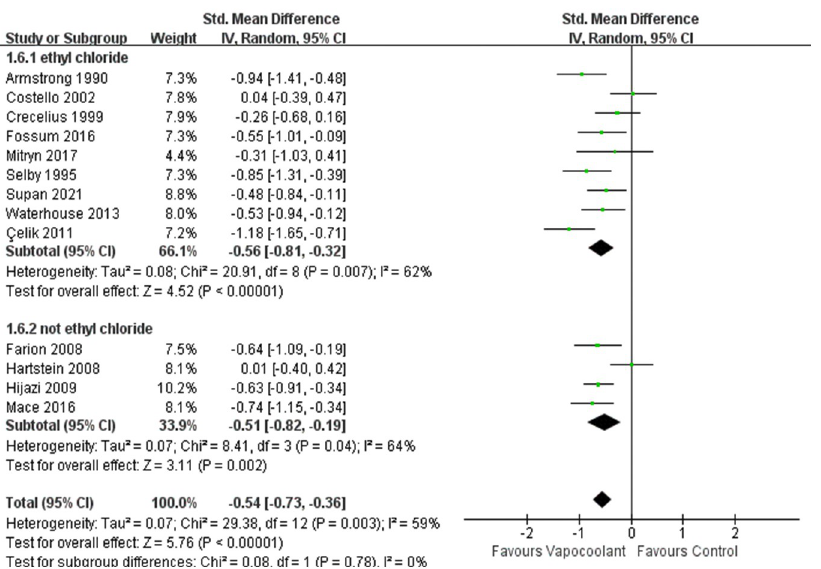
Fig 8. Subgroup analysis of pain scores during intravenous cannulation: Vapocoolants type ethyl chloride vs not ethyl chloride.